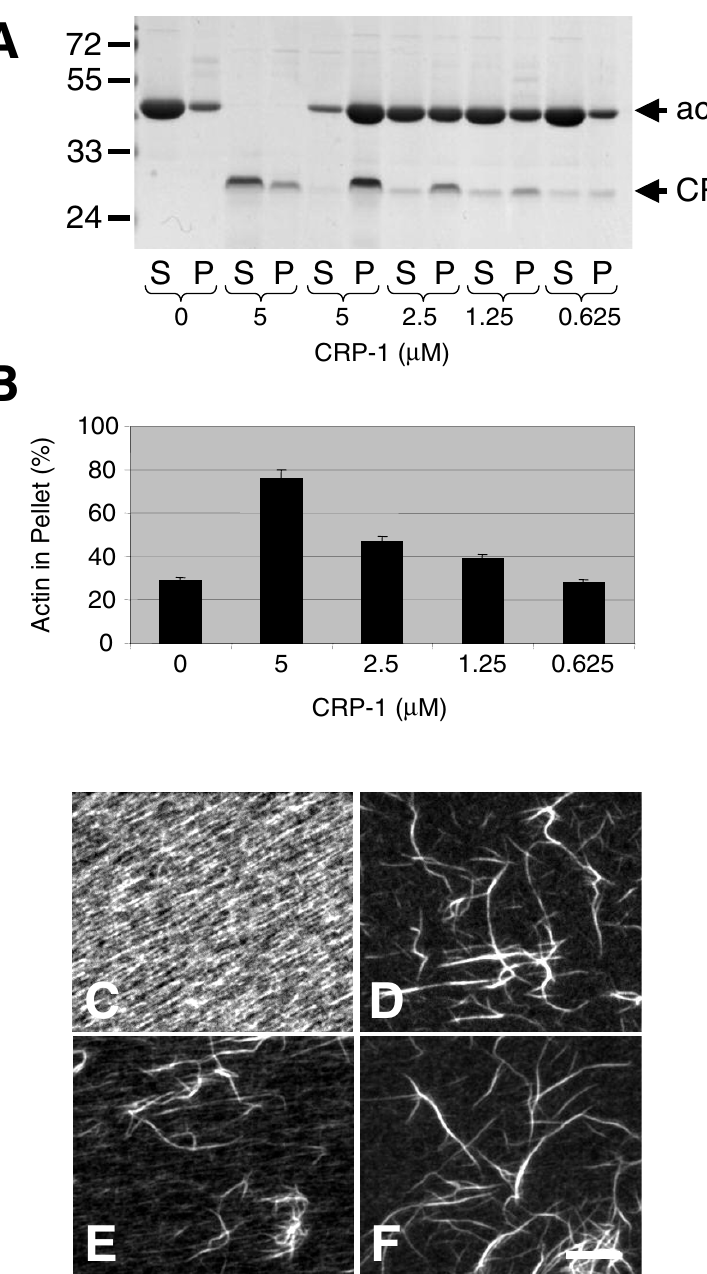
Figure 4 CRP1 bundles F-actin independently . The indicated concentration of CRP1 was incubated with actin filaments for 30 min at room temperature and centrifuged at 10,000 × g. Proteins from the supernatant (S) and the pellet (P) were separated by electrophoresis and detected by Gelcode Blue staining ( A ). The percentage of total actin in the pellet was quantified as described in Experimental Procedures ( B ). n = 4 ± SEM. Bundling reactions were also carried out on glass coverslips, fixed, and stained with rhodamine-phalloidin to allow visualization of the actin filaments bundles: ( C ) actin filaments, ( D ) actin filaments + 2.5 µ M α -actinin, ( E ) actin filaments + 5.0 µ M CRP1, and ( F ) actin filaments + 2.5 µ M α -actinin + 2.5 µ M CRP1. Results are representative of 4 separate experiments. Bar = 10 µ